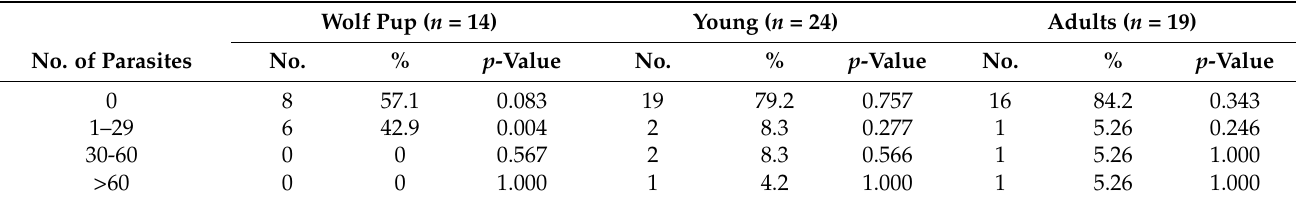
Table 3. Number of cardiorespiratory worms found per wolf according to host